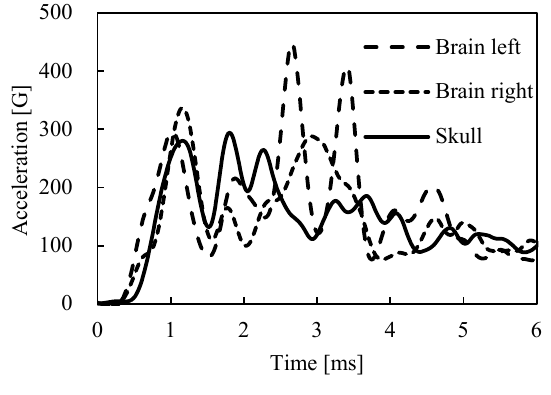
Figure 8. Resultant acceleration responses at the Brain Left, Brain Right and Skull points, where 6DOF sensors were inserted, in the case of ball impact simulations.